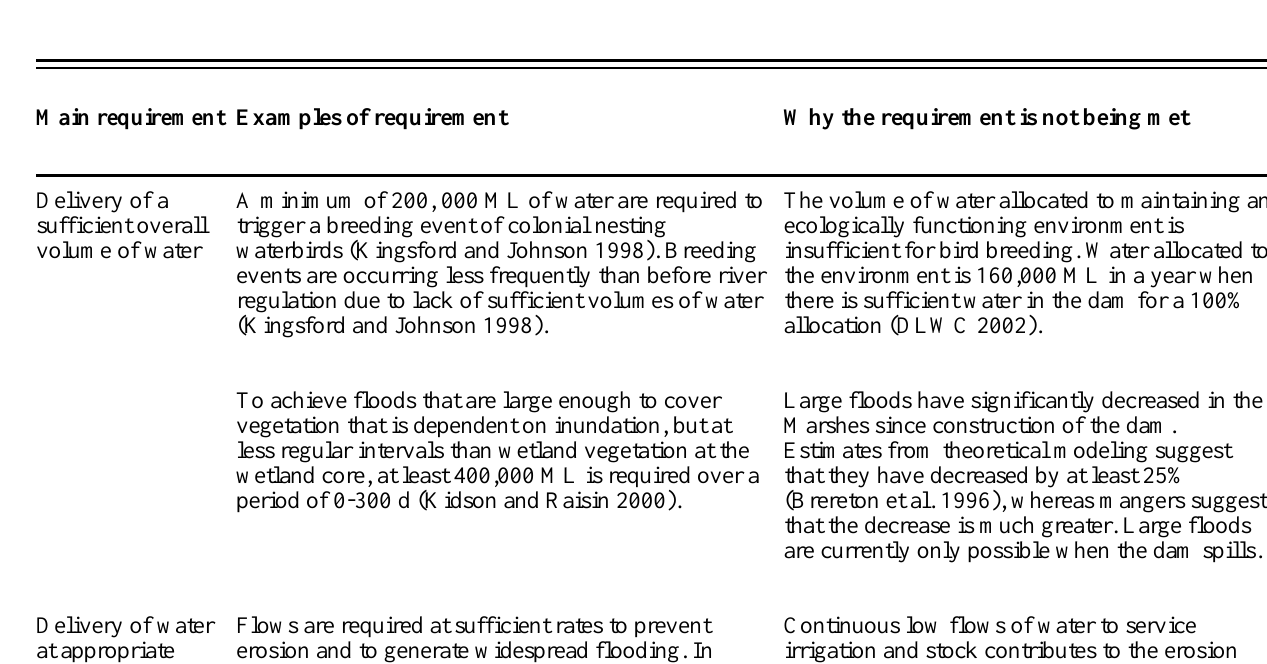
Table 1. The main requirements for achieving an appropriate flow regime for the Marshes. Only some of the examples are